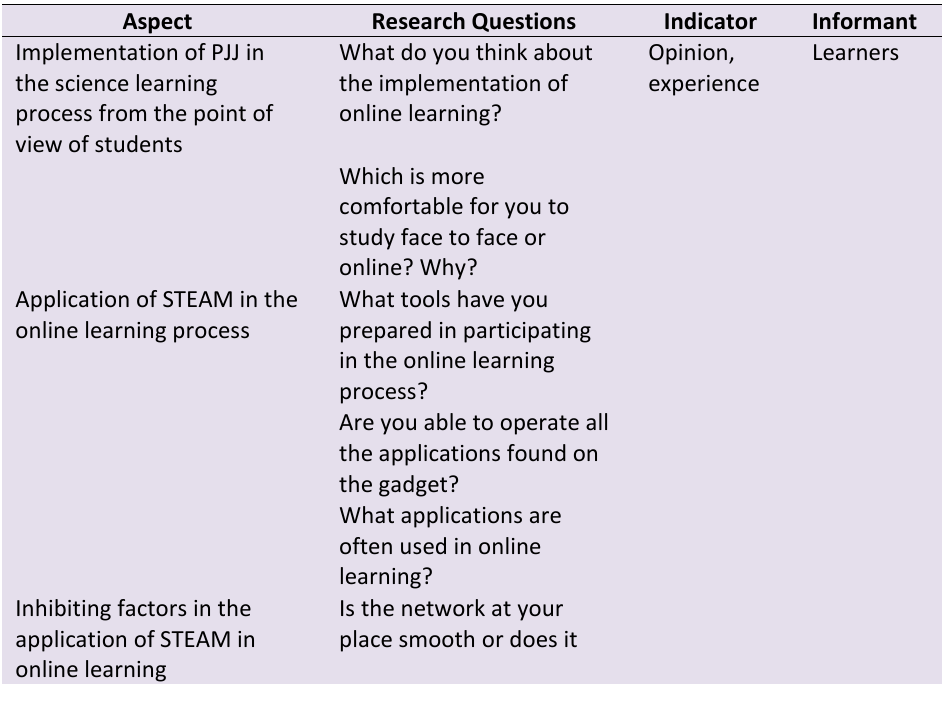
Table 2 . Interview Grid With